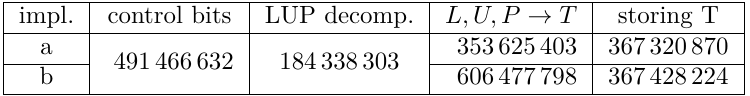
Table 2: Cycle counts for generating the control bits, the LUP decomposition, computing T from L, U, P , and storing each column block of T into flash memory.